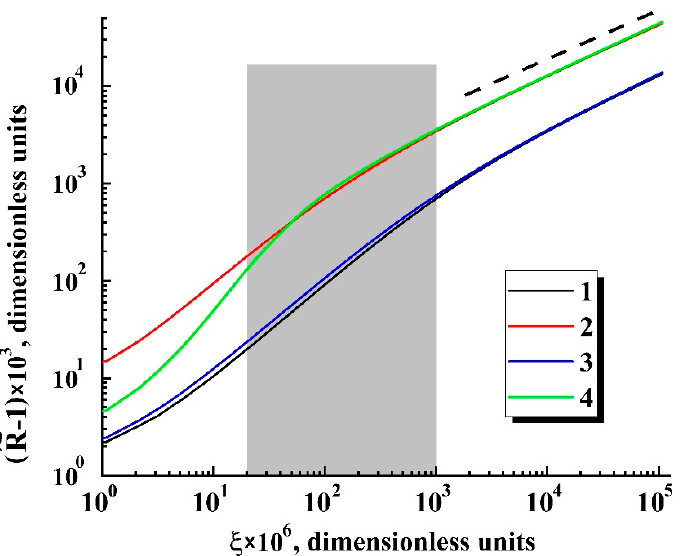
Figure 9. Expected variations of the normalized radii of embryos during the transient stage (re- sults of modeling). T = 310 K; 1— P int,0 = 4.0 MPa, Ξ = 0.001; 2— P int,0 = 4.0 MPa, Ξ = 0.01; 3— P int,0 = 8.3 MPa, Ξ = 0.001; 4— P int,0 = 8.3 MPa, Ξ = 0.01. The dashed line displays a trend to